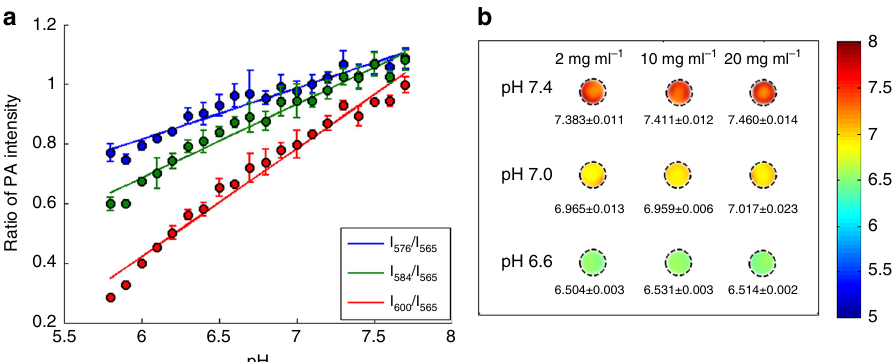
Fig. 4 Quad-wavelength ratiometric PA pH imaging of phantoms. a Measured PA signal amplitude ratios between the three wavelengths and the isosbestic point (i.e., 576 nm/565 nm, 584 nm/565 nm, and 600 nm/565 nm) from pH 5.8 – 7.7 with 0.1 pH interval ( n = 3, error bars represent standard deviations). By performing linear fi ttings of the scattered measurements in the range of pH 5.8 – 7.8, three calibration lines were generated. b Quantitative pH images of phantoms containing different concentrations (2, 10 and 20 mg ml − 1 ) of SNARF-PAA NPs buffered at different pH levels (pH 6.6, 7.0 and 7.4). The means and the standard deviations of the pH levels in each PA image were calculated. The measurement accuracy was better than 0.1 pH. The presence of whole blood (1%, w/w) did not affect the quanti fi cation of pH levels